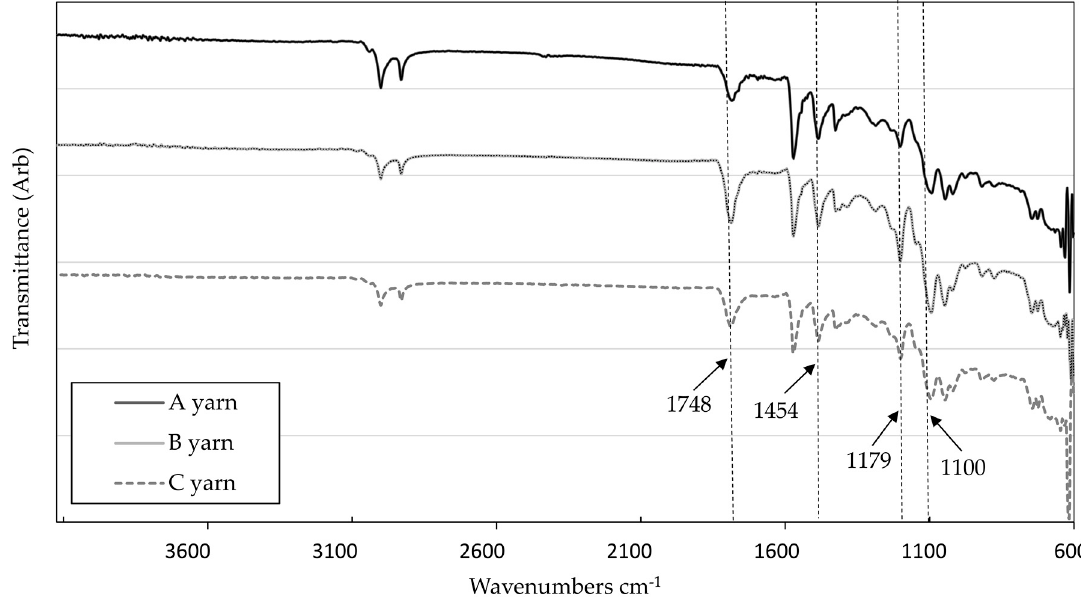
Figure 7. ATR–FTIR spectrum of di ff erent PLA multifilament samples. A—pure PLA polymer; B—PLA polymer modified with ethanolic myrrh extract; C—PLA polymer modified with aqueous myrrh